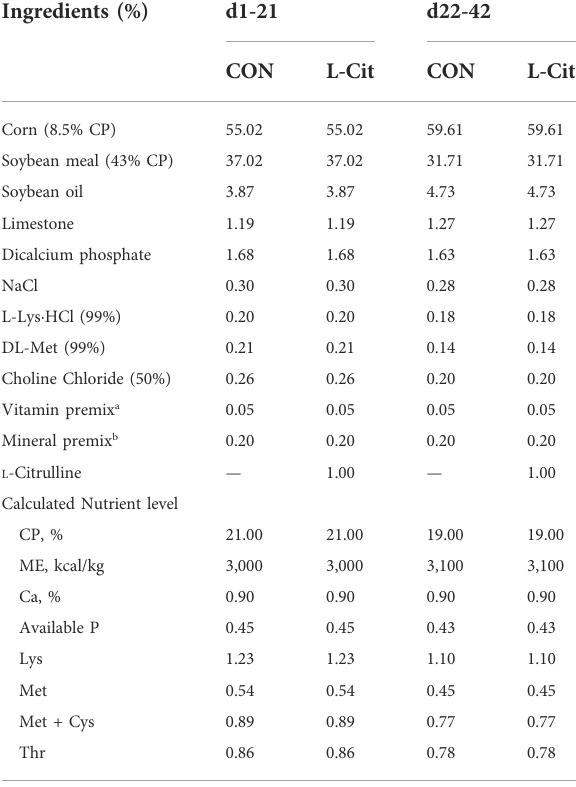
TABLE1Compositionandnutrientlevelsofexperimentaldiets(as-fed basis) %. Ingredients